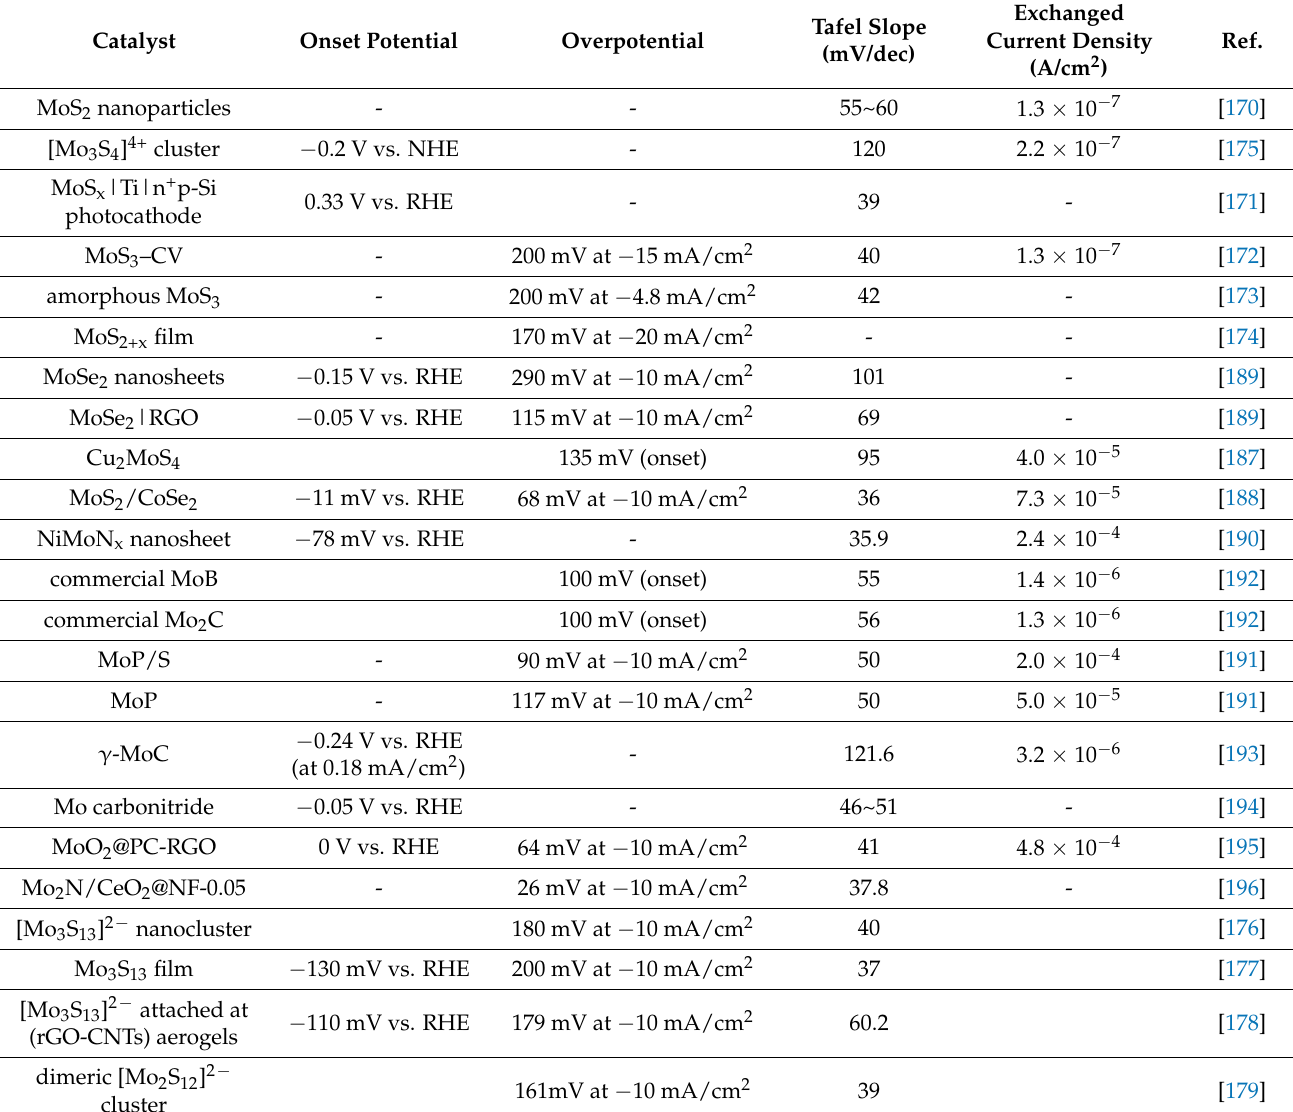
Table 3. Compared catalytic efficiencies of Mo-based HER